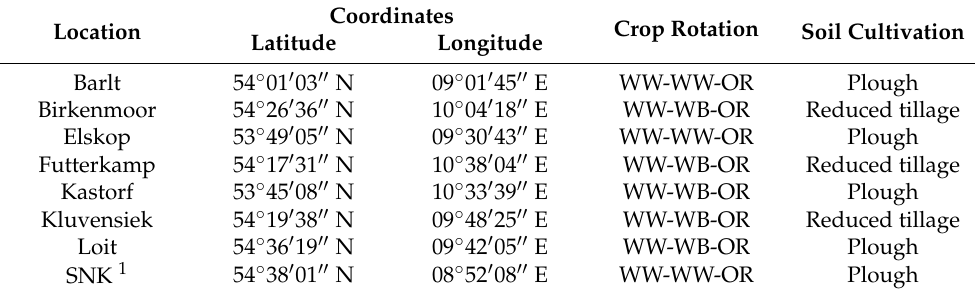
Table 1. Coordinates and agronomic practices (crop rotation, soil cultivation) of the eight trail locations of the regional wheat disease monitoring in northern Germany from 1995 to 2021. WW = winter wheat, WB = winter barley, OR = oilseed